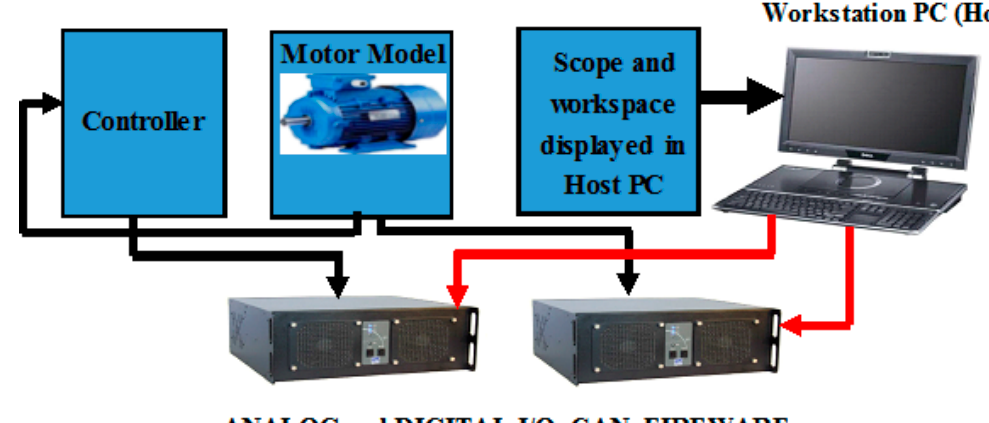
Figure 2. Block diagram of real time implementation.